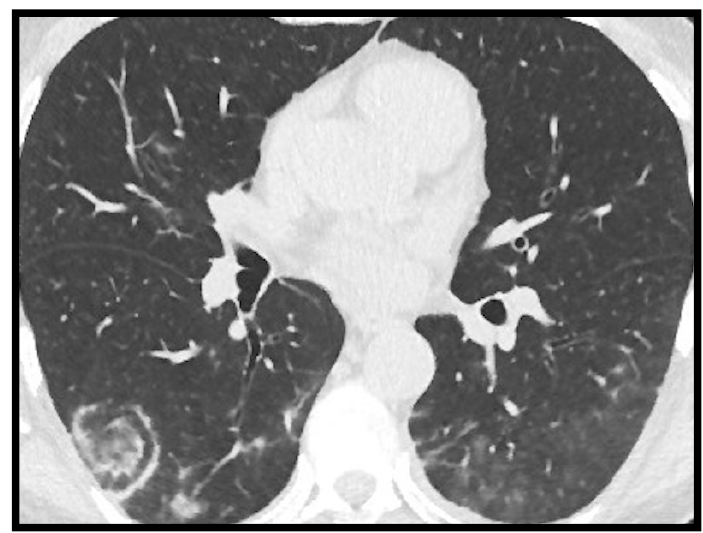
Figure 5. Reverse halo sign in right lower lobe in COVID-19.